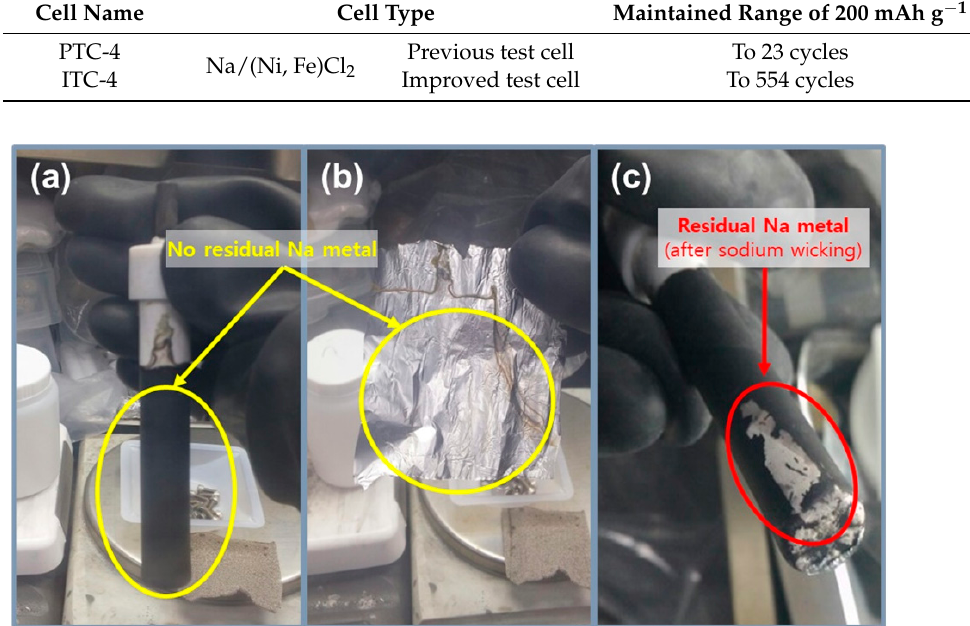
Table 1. Initial charge capacity of previous test cells and improved test cells, and maximum charge capacity gap of each group.